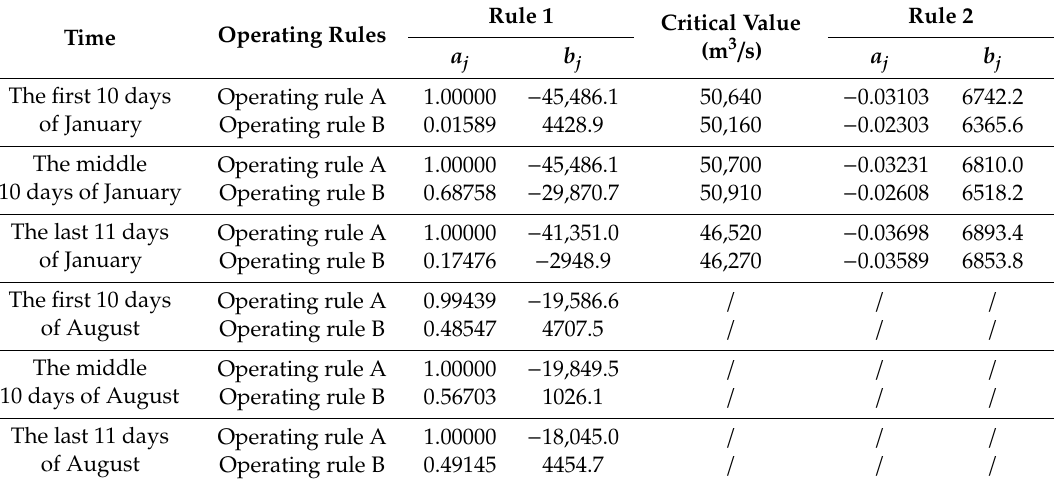
Table 1. Derived operating rules A and B for TGR in January and August.